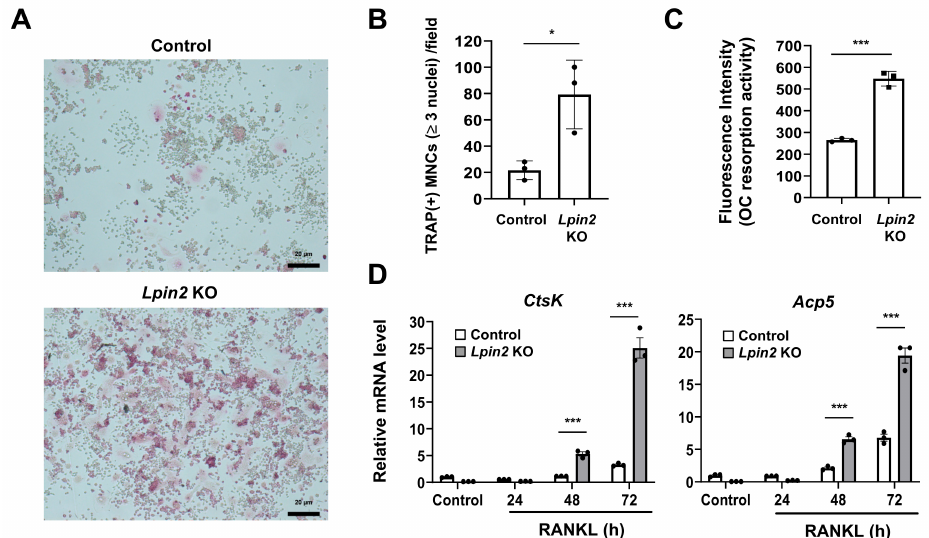
Figure 5. Lipin2 deficiency promotes RANKL-mediated osteoclast formation in RAW-D cells. ( A ) Tartrate-resistant acid phosphatase (TRAP) staining of multinuclear cells (MNCs). Control (WT) and Lpin2 KO RAW-D cells were cultured in the presence of 50 ng/mL RANKL for 3 d and fixed for staining. Scale bar, 20 µ m. Magnification, 50 × . ( B ) TRAP-positive MNCs with ≥ 3 nuclei were counted for each group. Data are means ± SD ( n = 3). * P < 0.05, Student’s t -test. ( C ) Quantification of osteoclastic (OC) resorption activity. Control and Lpin2 KO RAW-D cells were cultured in fluoresceinated calcium phosphate-coated plates in the presence of 100 ng/mL RANKL for 3 d. OC resorption activity was evaluated by measuring fluorescence intensity in conditioned medium. Data are means ± SD ( n = 3). *** P < 0.001, Student’s t -test. ( D ) RT-PCR was performed to determine relative mRNA expression levels of the osteoclastic marker genes Ctsk and Acp5 in control and Lpin2 KO RAW-D cells treated with 50 ng/mL RANKL. The cells were harvested for RNA extraction at the indicated time points. Gapdh was used for normalization. Data are means ± SEM ( n = 3). *** P < 0.001. One-way ANOVA followed by the multiple comparisons